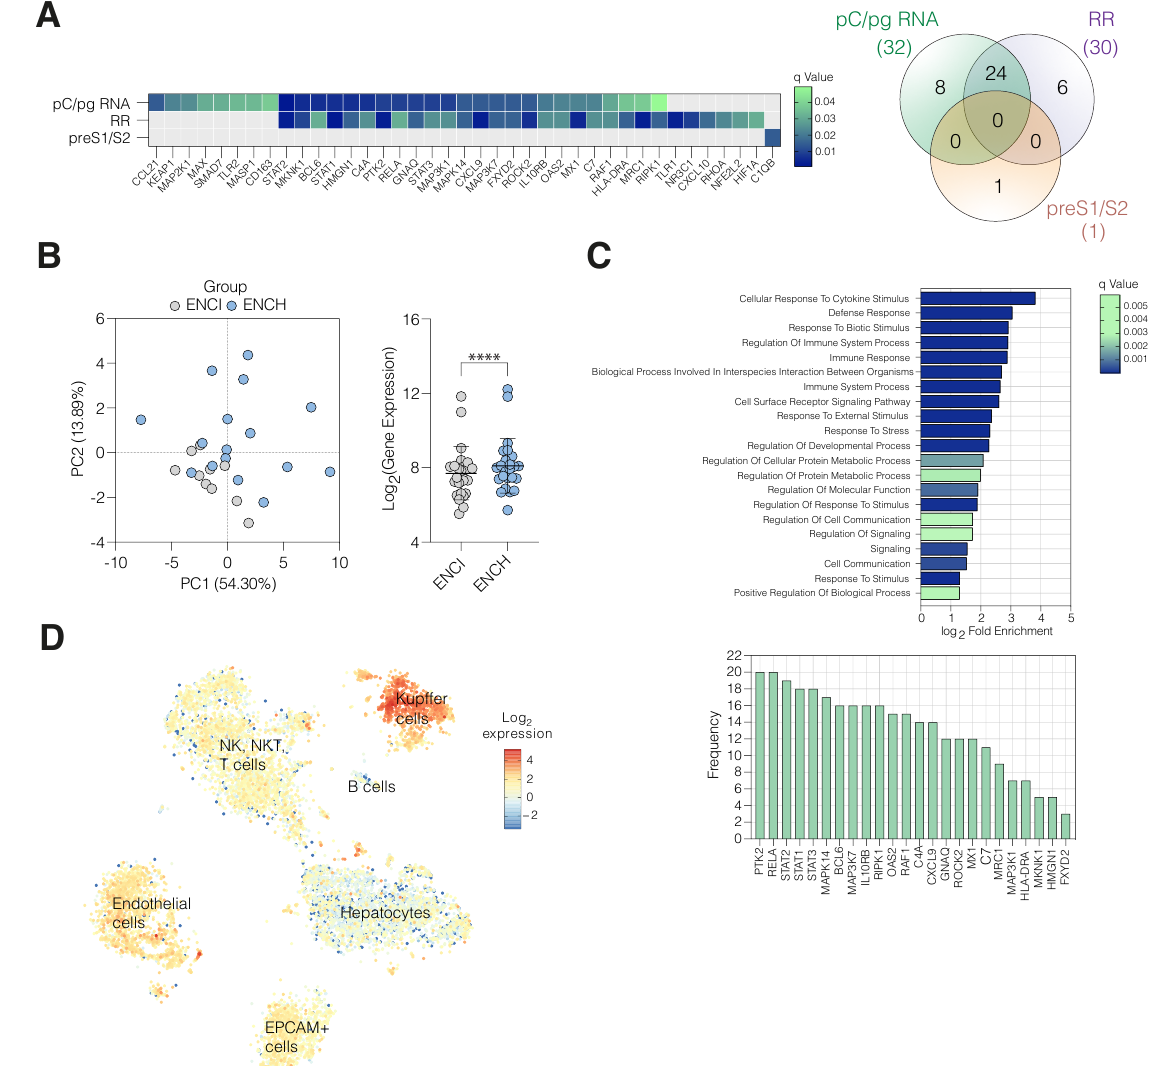
Figure 5. HBV transcripts and inflammation. ( A ) Heatmap and Venn diagram depicting the q-value and inflammatory gene transcripts that positively associate with pC/pg, RR, or preS1/S2 RNAs from CHB biopsies and their overlap. Probabilities were estimated using Spearman’s rank correlation coefficient with p -values corrected for a 5% false discovery rate (FDR) using the two stage Benjamini– Krieger–Yekutieli method. ( B ) Principal component analysis of the 24 genes associated with pC/pg RNA and RR identified in ( A ) stratifies patients according to their EASL disease staging (ENCI- grey and ENCH- blue). Average expression of the 24 gene signature in biopsies from patients diagnosed as ENCI or ENCH (Wilcoxon signed-rank test, **** p < 0.0001). ( C ) Pathway analysis of enriched GO biological processes were determined using PantherDB and redundancy accounted for using REVIGO. 21 pathways were identified where at least half of our gene set was represented. ( D ) Cell-type-specific expression of the 24 inflammatory genes in the human liver single cell atlas [23], where data is presented as the mean of the log2-transformed